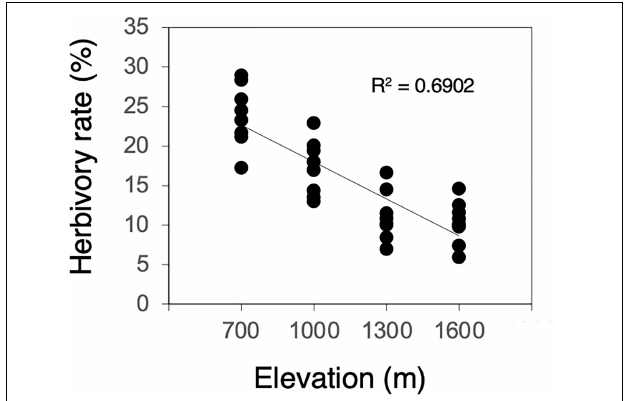
FIGURE 1 | Correlation between herbivory rate and elevation ( n = 32). Solid line denotes significant correlation.